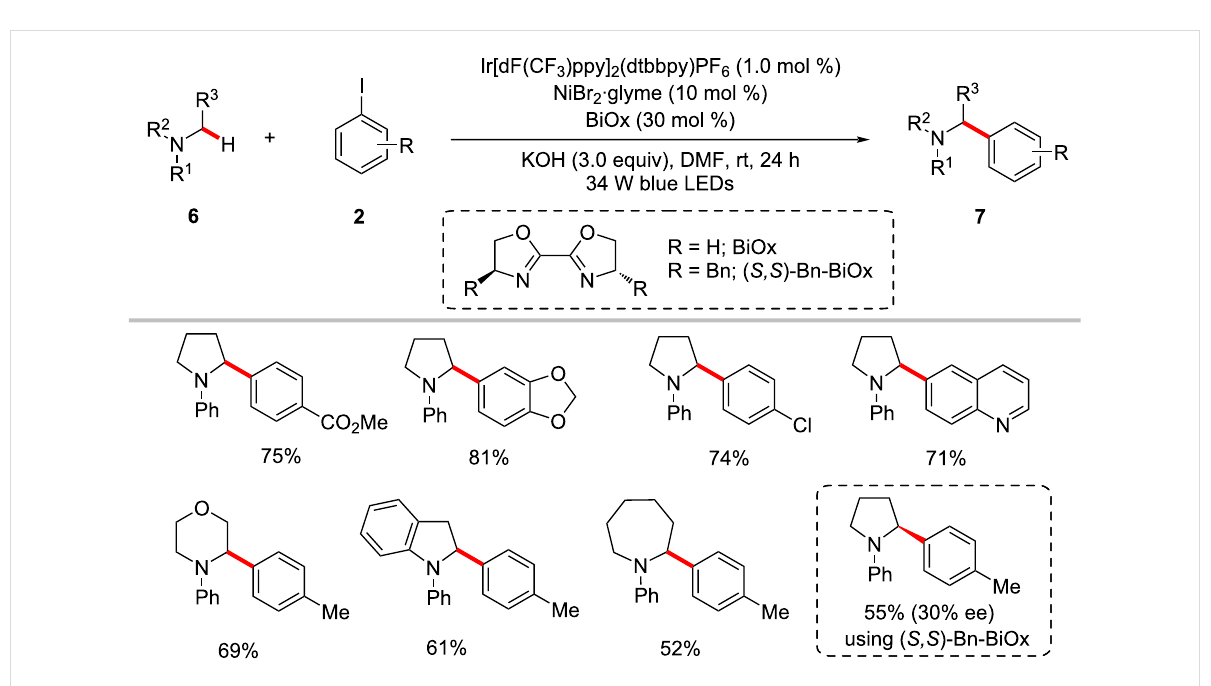
Scheme 4: Photoredox arylation of α -amino C(sp 3 ) ‒ H bonds with aryl